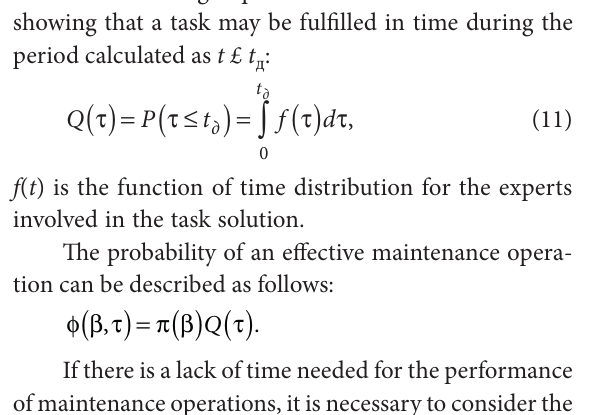
Availability of data β ' ; M(T); D(T)